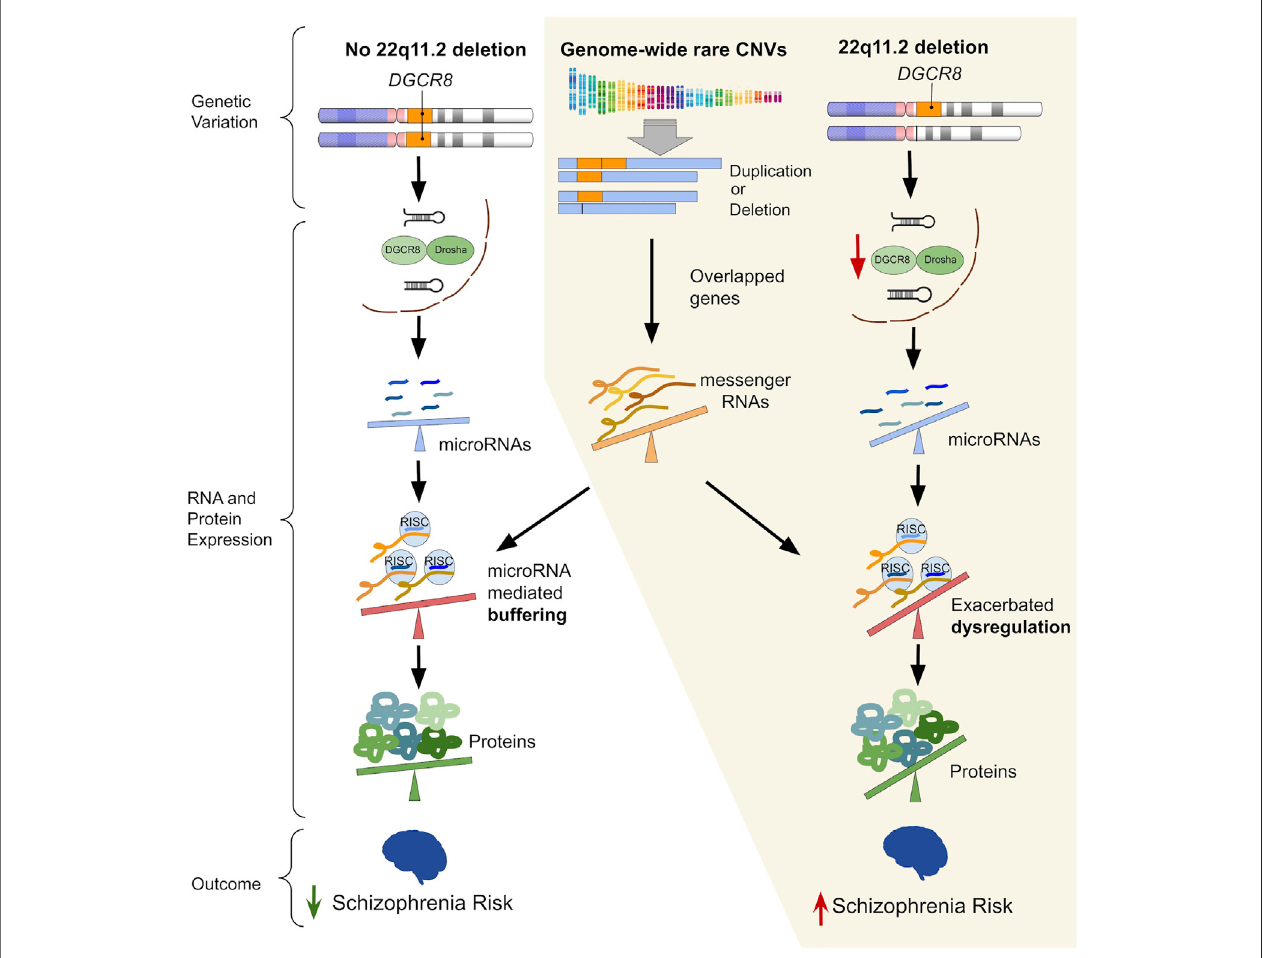
FIGURE 1 | The left-hand column ( “ No 22q11.2 deletion ” ) illustrates the ability of an intact microRNA (miRNA) regulatory system to buffer the effects of genetic variation that would otherwise perturb gene expression. The parts grouped by the yellow background illustrate the proposed mechanism of how widespread miRNA dysregulation imparted by the 22q11.2 deletion may exacerbate the downstream impact of rare genome-wide copy number variants (CNVs), thereby increasing risk for schizophrenia. Hemizygosity of DGCR8 duetothe 22q11.2 deletion leadstoreducedprocessing ofprimary-to pre-miRNAs in miRNA biogenesis,thus resulting in widespread miRNA dysregulation. Subsequently, an altered degree of miRNA targeting of differentially expressed messenger RNA (mRNA) transcripts (due to overlapping rare CNVs) may amplify dysregulation of protein expression. A steeper tilt of the seesaws represents a greater degree of dysregulation (i.e., upregulation or downregulation) of miRNAs, mRNAs, proteins, or miRNA mediated repression/degradation of its target mRNA.